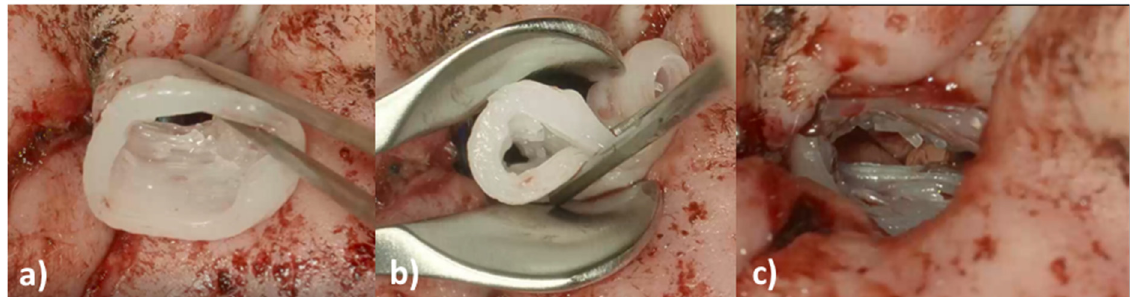
Figure 8. Intraoperative images of the insertion of the 3D-printed, individualized, drug-releasing EECI. ( a ) After surgically removing the stenosis of the EEC, the EECI was inserted in the right position according to the patient’s anatomy; ( b ) the texture of the implant was deformable for better handling while insertion with the forceps; ( c ) perfectly fitted implant in the EEC of the patient.